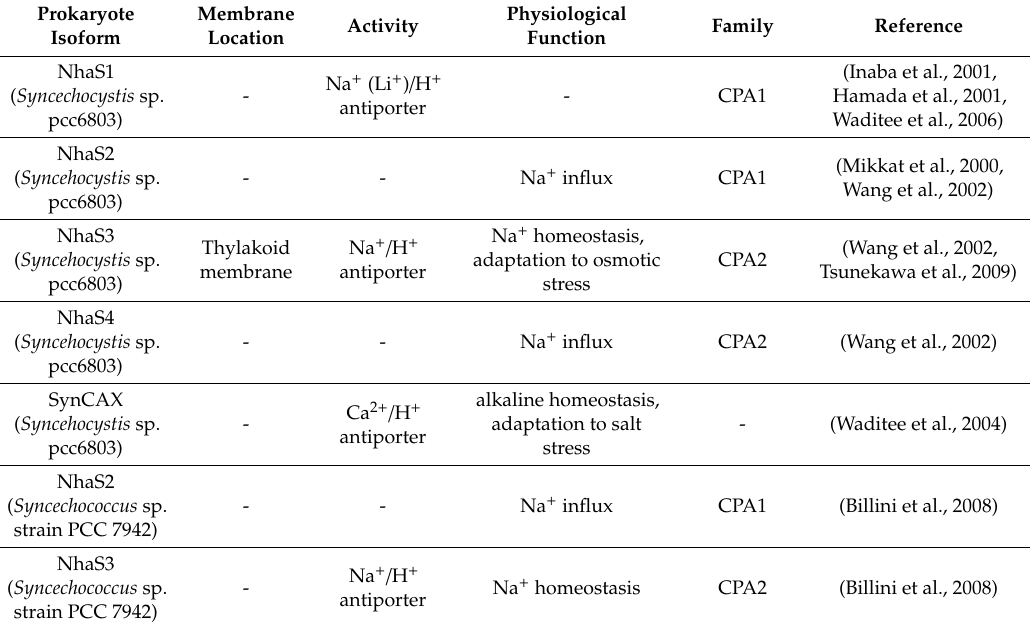
Table 2. CPAs in